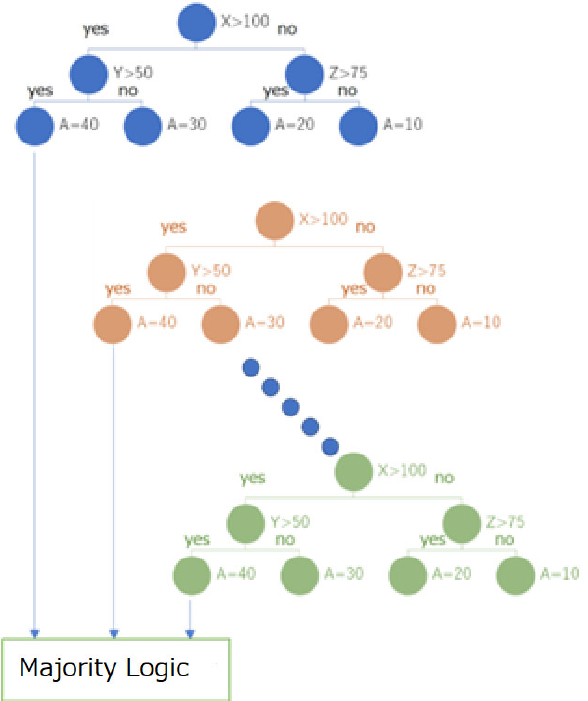
Figure 6. Application of the proposed GCN and GNN for RFBD learning processes.